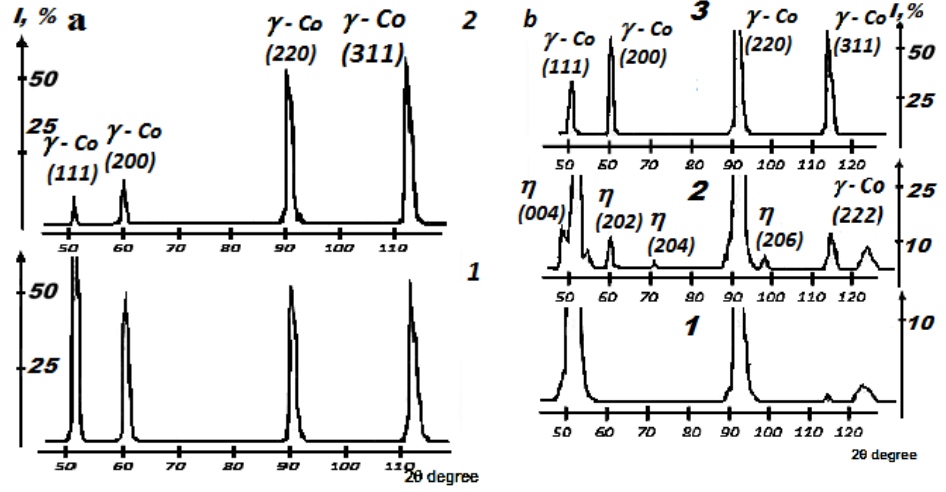
Figure 2. Fragments of diffractograms of Co-Ni-Nb alloy: ( a ) after quenching at 1223 K (10 min) ( 1 ) and at 1423 K (10 min) ( 2 ); ( b ) after annealing at 773 K (1 h) ( 1 ), 973 K (1 h) ( 2 ) and at 1173 (1 h) ( 3 ).